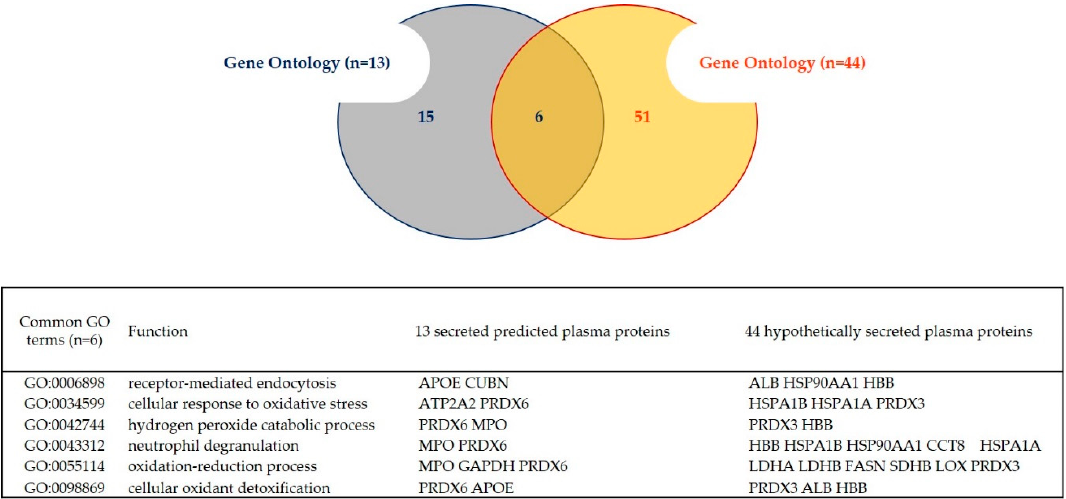
Figure 3. Comparison of the list of Gene Ontology terms identified in the 13 secreted plasma proteins + plasma and 44 hypothetically secreted proteins + plasma.